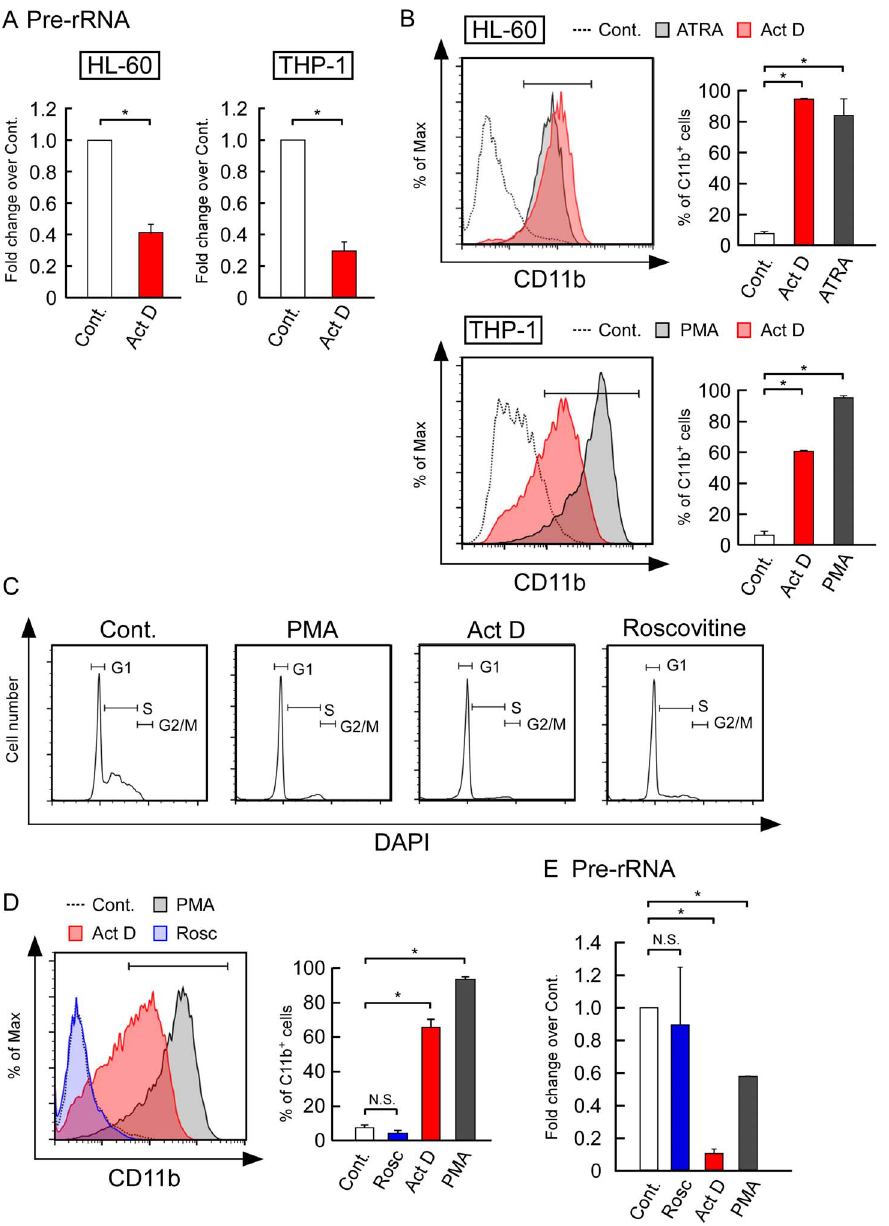
Figure 1. Suppression of rRNA transcription by actinomycin D (Act D) induced the differentiation of HL-60 and THP-1 cells. (A) A low concentration of Act D inhibited rRNA transcription in HL-60 and THP-1 cells. HL-60 and THP-1 cells were treated with 5 nM Act D for 24 h. The levels of pre-rRNA were determined by real-time quantitative PCR (RT-qPCR) and normalized by cell number. (B) Act D induced the expression of CD11b in HL-60 and THP-1 cells. Cells were cultured in the absence (control) or presence of all-trans-retinoic acid (ATRA) (1 m M), PMA (10 ng/mL), or Act D (5 nM) at 37 u C. After 3 days, the CD11b expression levels were determined by flow cytometry (left panels). The corresponding mean percentages of CD11b-positive cells are shown in the left panels (right panels). (C, D) Inhibition of the cell cycle did not affect CD11b expression. THP-1 cells were treated with PMA (10 ng/mL), Act D (5 nM), or roscovitine (15 m M) for 3 days. (C) The DNA content was determined by DAPI and analyzed by flow cytometry. Similar results were obtained in three independent experiments. (D) The CD 11b expression levels were determined by flow cytometry. The corresponding mean percentages of CD11b-positive cells are shown in the left panels (right panels). (E) Roscovitine treatment did not affect the pre-rRNA levels. THP-1 cells were treated with PMA (10 ng/mL), Act D (5 nM), or roscovitine (15 m M) for 3 days. The pre-rRNA levels were determined by RT-qPCR and normalized by cell number. Values are expressed as the mean 6 S.D., n =3. * P , 0.05. N.S.: P . 0.05.